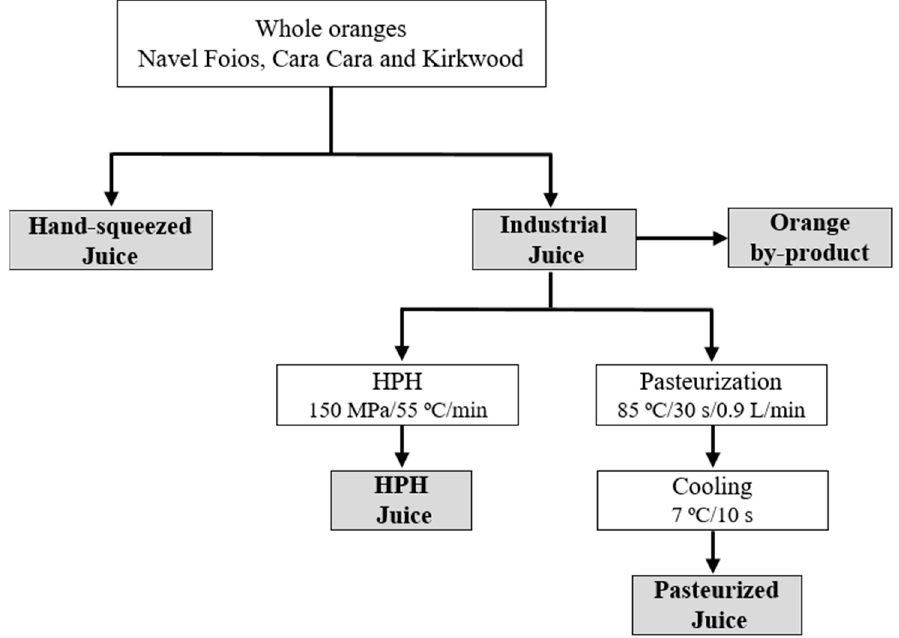
Figure 2. Flow diagram of the experimental design. HPH: high-pressure homogenization.